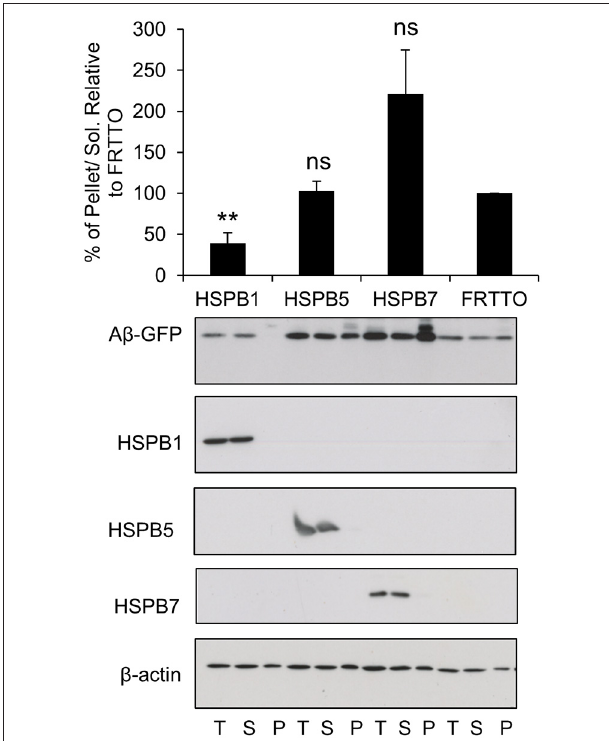
FIGURE 3 | Canonical members of HSPB family prevent the aggregation of A β -GFP. Cells were transfected with HSPB1, HSPB5, HSPB7 or FRTTO at 1:3 ratio for 48 h. Quantification of the pellet/soluble ratio of A β -GFP relative to FRTTO was depicted in the chart above the blot. Values represent mean ± SE of two independent experiments. ∗∗ P < 0.01, ns = non significant.